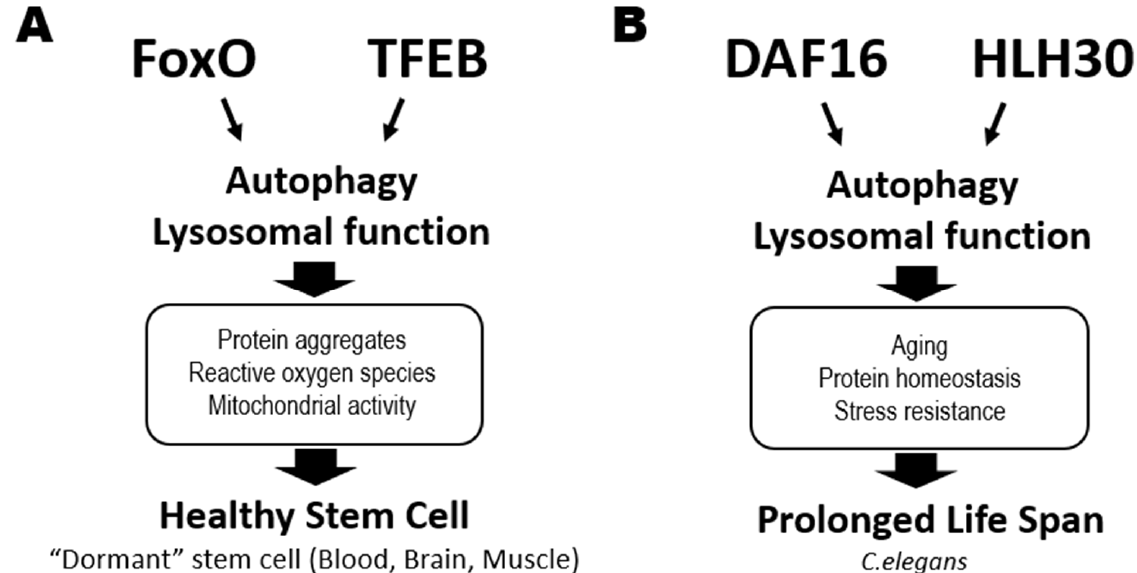
Figure 2. Critical roles of catabolic regulators in organismal life extension and the maintenance of healthy stem cells. ( A ) In mammalian stem cells, activation of the FoxO and TFEB transcription factors triggers autophagy and lysosomal functions that help to maintain tissue stem cell quiescence or dormancy in an animal at steady-state. This process reduces the accumulation of protein aggregates and ROS and suppresses mitochondrial activity in stem cells in blood (HSCs), brains (NSCs) and muscle (MuSCs), sustaining their good health. ( B ) DAF16 and HLH30 are the homologs of FoxO and TFEB, respectively, in C. elegans . These transcription factors also cooperate to regulate genes involved in autophagy and lysosomal functions, which prolong a worm’s lifespan by maintaining protein homeostasis and increasing stress